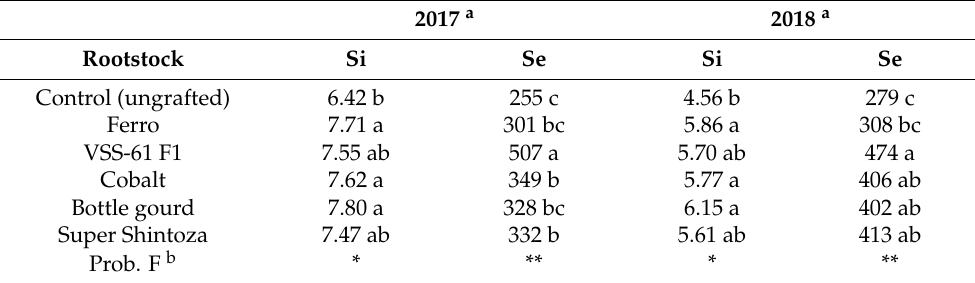
Table 7. Means of silicon (Si) and selenium (Se) contents in the leaves of cucumber Gianco F1, grafted onto five cucurbit rootstocks and the ungrafted control, under heat and salinity stresses in the 2017 and 2018 seasons. Results are expressed in percentage over dry weight (Si) and mg kg − 1 (Se). Details on the measurement of the traits presented are provided in the Material and Methods Section.